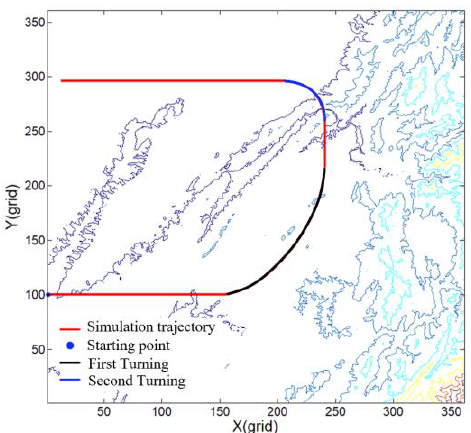
Figure 5. The terrain contour map.